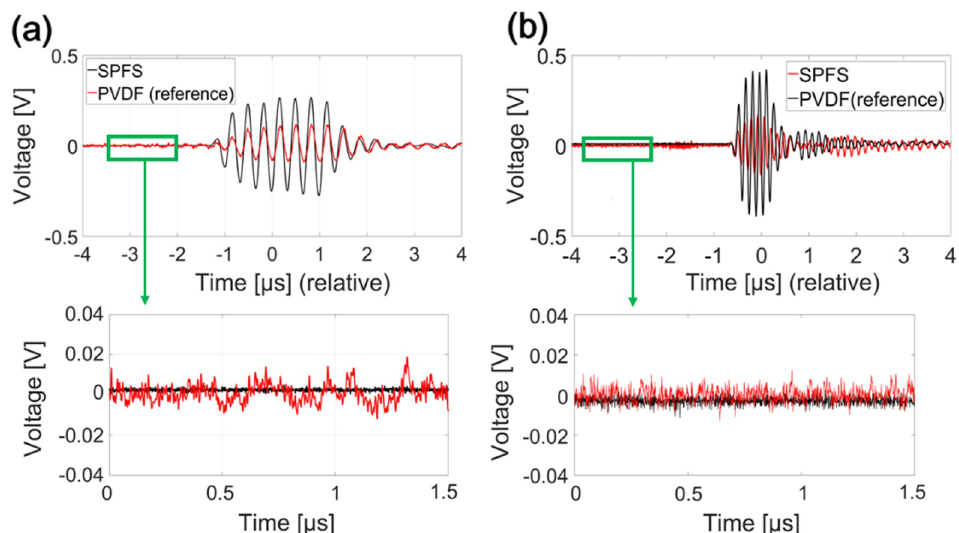
Figure 6. Temporal waveforms measured by SPFS and reference hydrophone for acoustic inputs with ( a ) 3-MHz and ( b ) 7-MHz frequencies (P in = 120 mW). The bottom figures show enlarged views for early periods used for noise analysis (green boxes of the top figures) before the major signal traces arrive.